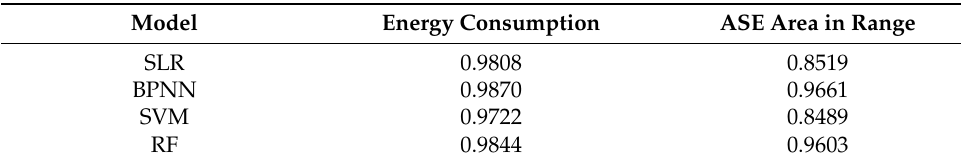
Table 7. R-square of Each